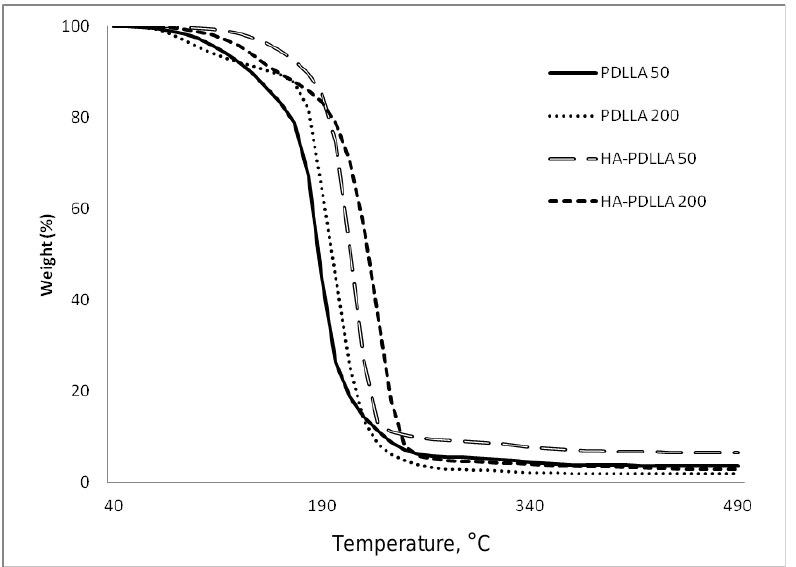
Figure 5. TGA thermograms of PDLLA 50, PDLLA 200 and the corresponding grafts, HA-PDLLA 50 and HA-PDLLA 200.